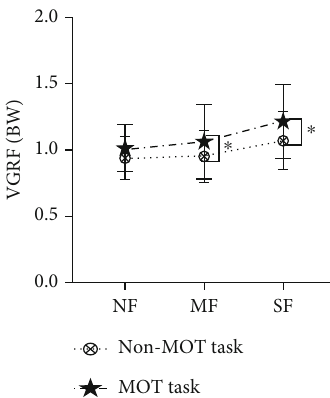
Figure 7: Changes of ground reaction